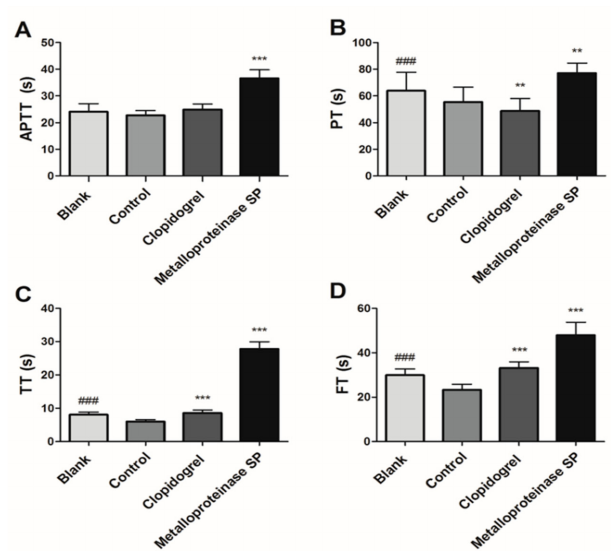
Figure 4. E ff ects of metalloproteinase SP on acute pulmonary embolism coagulation. Compared with blank group, the activated partial thromboplastin time (APTT), thrombin time (TT), prothrombin time (PT), and fibrinogen time (FT) of the control group exhibited significant di ff erence (*** p < 0.001). Compared with control group, the metalloproteinase SP group could prolong the APTT, PT, TT, FT. ( A ) Activated partial thromboplastin time (APTT). ( B ) Thrombin time (TT). ( C ) Prothrombin time (PT). ( D ) Fibrinogen time (FT). All data were expressed as mean ± SD, compared with the control group, ** p < 0.01 ***, p < 0.001, and compared with the blank group ### p < 0.01.